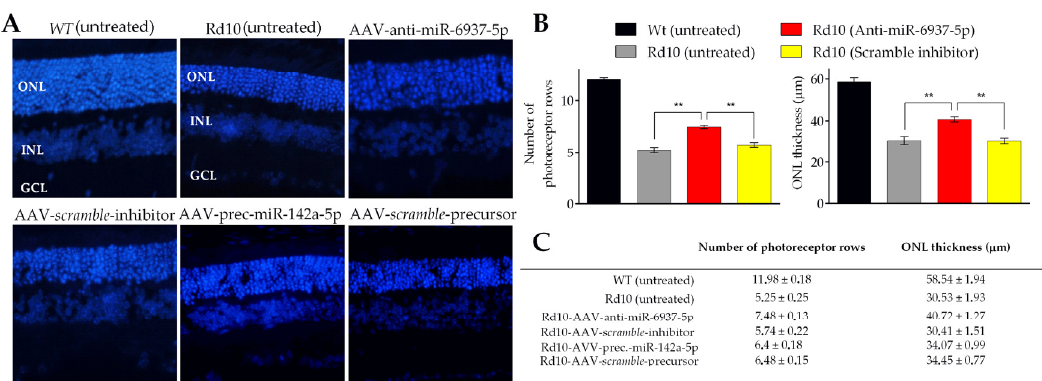
Figure 3. Histological analysis of rd10 mice retinas treated with miRNA modulators. ( A ) A significantly increased ONL (nuclei stained with DAPI) is observed in the retinas of rd10 mice treated with mir-6937-5p inhibitors, whereas no differences are observed in the rest of the conditions analyzed. Sections of untreated retinas from wild-type and rd10 mice are shown for comparative purposes . ( B ) Histograms show the mean values of the number of photoreceptor nuclei rows (left) and outer nuclear layer (ONL) thickness (right) from the retinas of rd10 mice submitted to miR-6937-5p inhibition. We used retinas from rd10 mice injected with scramble miRNA sequences as controls. Values from untreated wild-type (WT) and rd10 mice are also shown. ( C ) Summary of histological parameters analyzed. Abbreviations. GCL: ganglion cell layer; INL: inner nuclear layer; ONL: outer nuclear layer. Data are presented as mean values ± S.E.M. ** p < 0.01 (Student’s t -test).